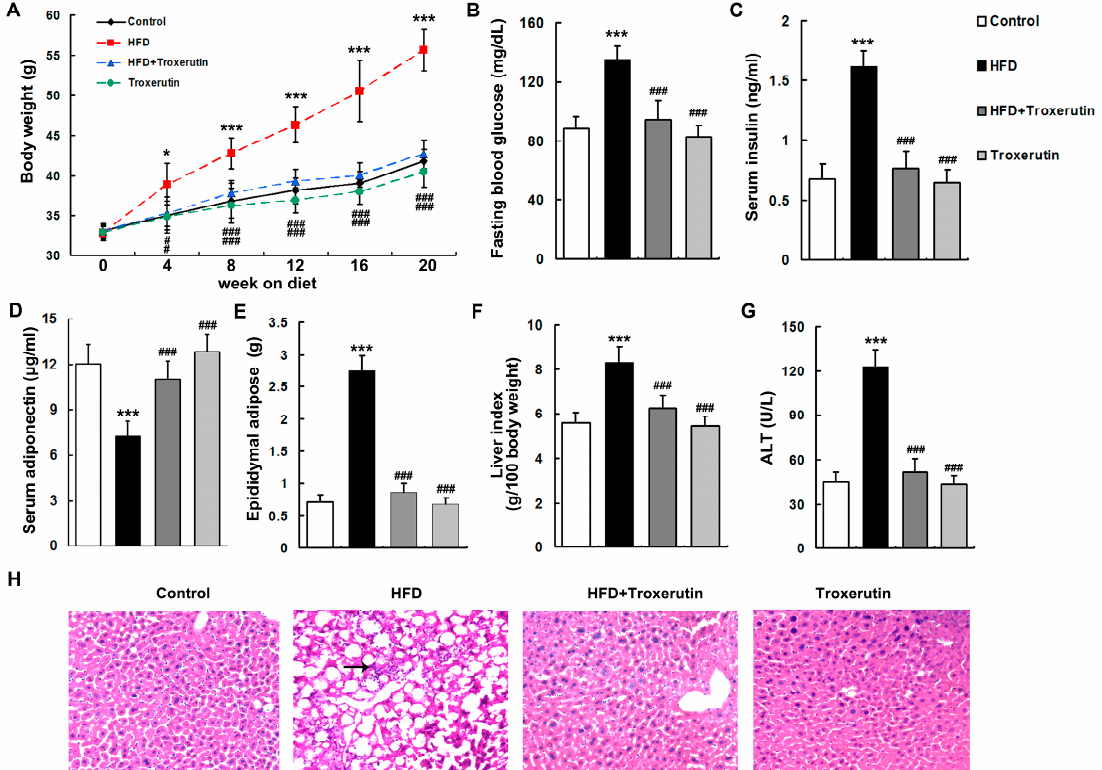
Figure 1. Troxerutin improves obesity and related metabolic parameters, and liver injuries in high-fat diet (HFD)-treated mouse ( n = 5). ( A ) Total body weight in all treated groups; ( B ) The levels of fasting blood glucose in all treated groups; ( C ) The levels of serum insulin in all treated groups; ( D ) The levels of serum adiponectin in all treated groups; ( E ) The levels of epididymal adipose tissue masses in all treated groups; ( F ) The levels of liver index in all treated groups; ( G ) Serum alanine aminotransferase (ALT) activities in all treated groups; ( H ) H&E staining of liver sections, 200 × magnification. Inflammatory cells are indicated by black arrow. All of the values are expressed as the mean ± SD. * p < 0.05, *** p < 0.001 vs. the control group; ### p < 0.001 vs. the HFD group.